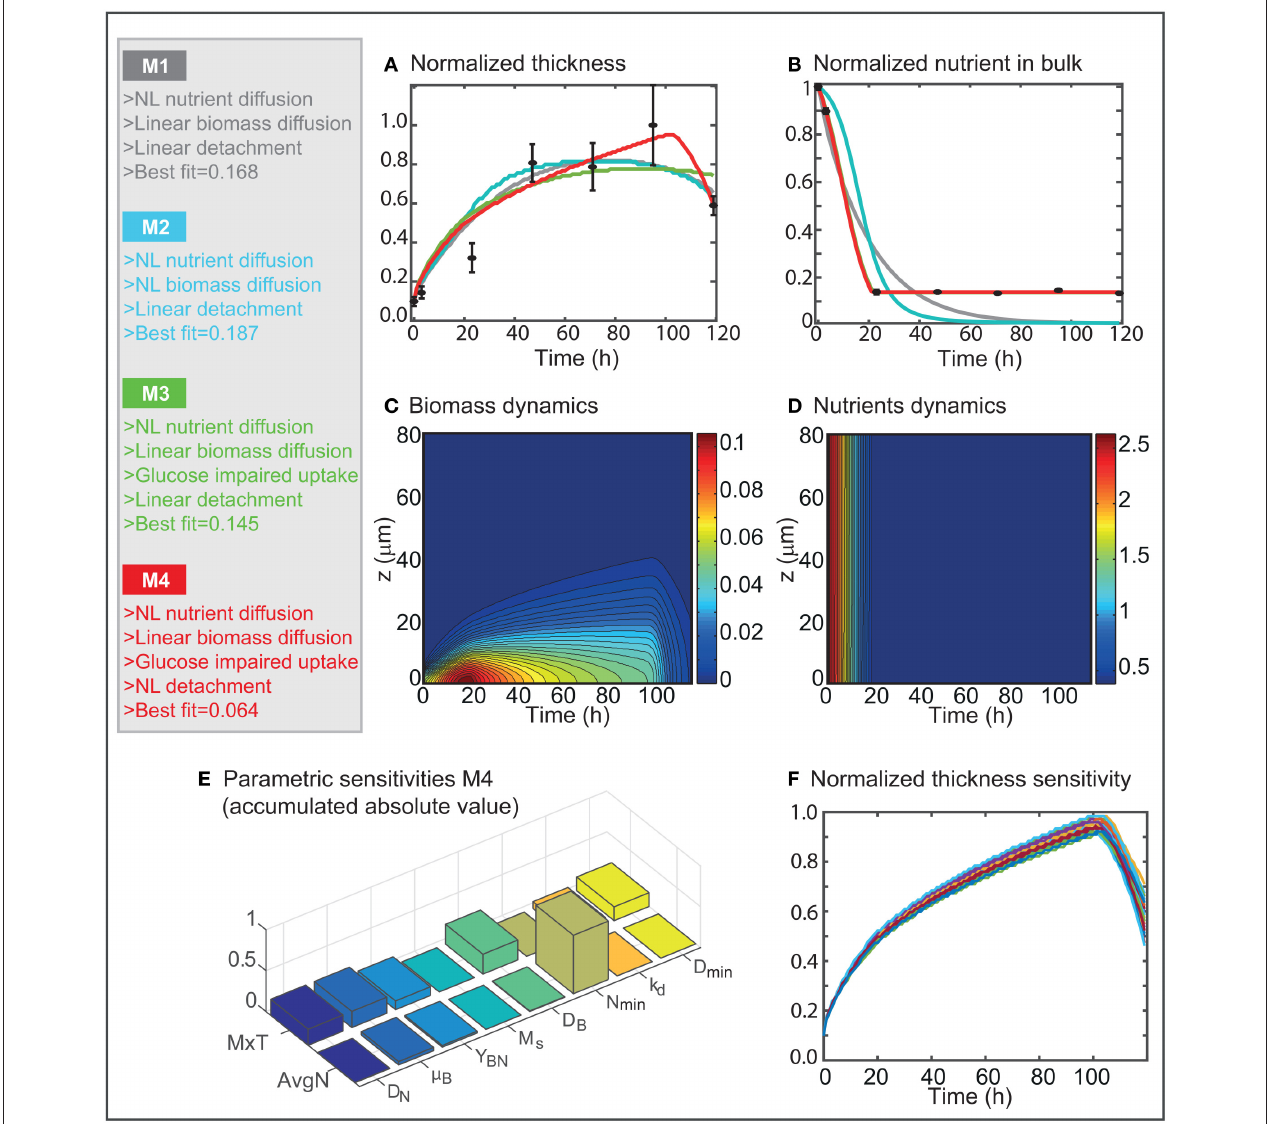
FIGURE 5 | Candidate models analysis. (A,B) Present the best fit to the data obtained for the different candidate models. (C,D) Show the spatio-temporal dynamics of the biomass and nutrients concentrations as predicted by the most successful model M4. (E) Shows the absolute value of the relative parametric sensitivities as computed for M4. (F) Presents the effect of modifying the parameter values on